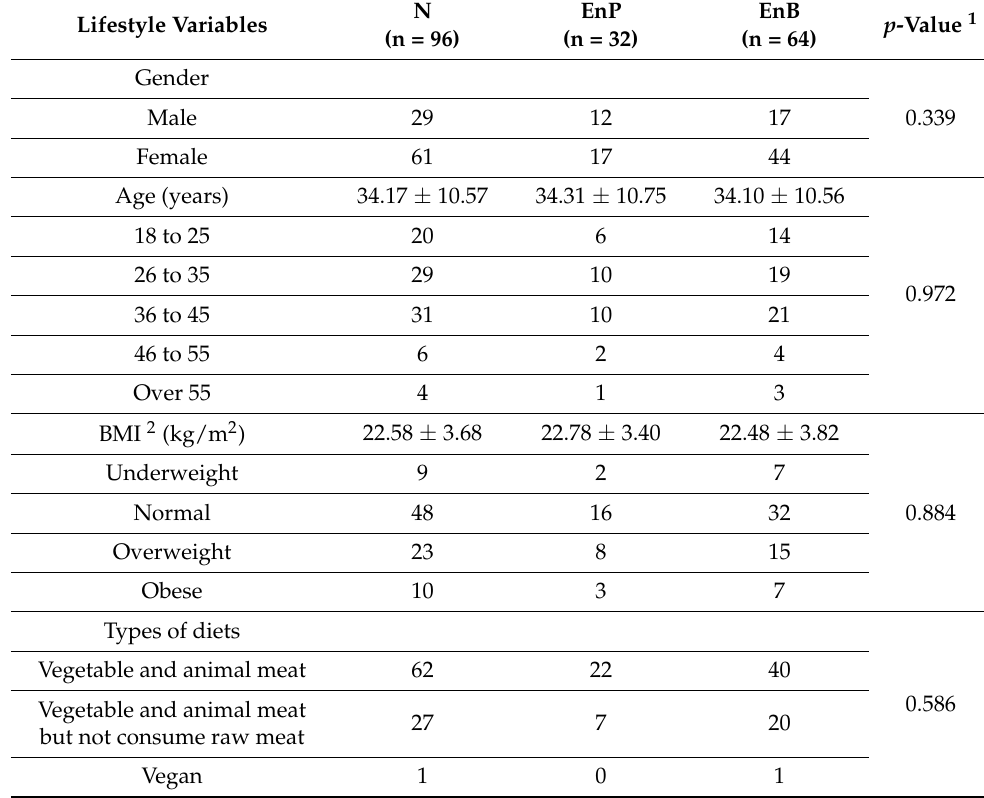
Table 1. Characteristics of participants in each